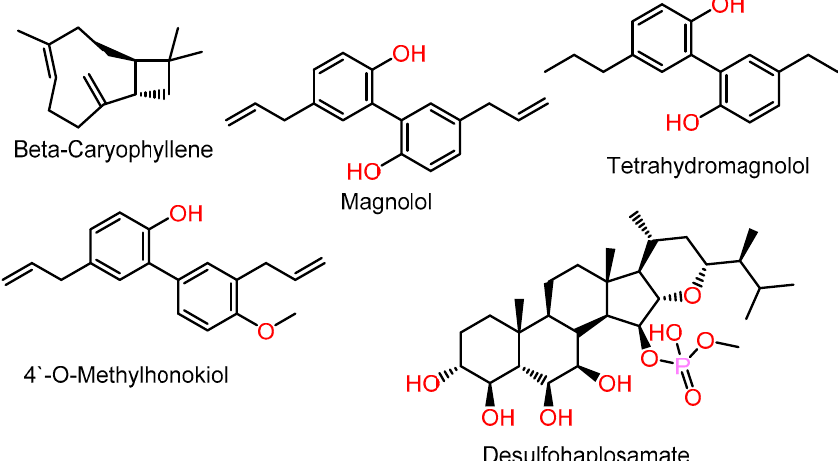
Figure 1. Examples of selective CB2R agonists.